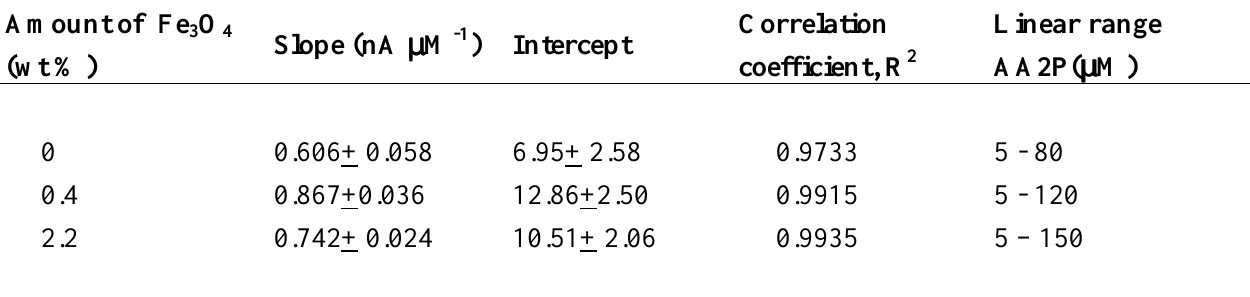
Table 1. The calibration curves of the biosensor with and without immobilized Fe nanoparticles in the presence of various concentrations of AA2P.